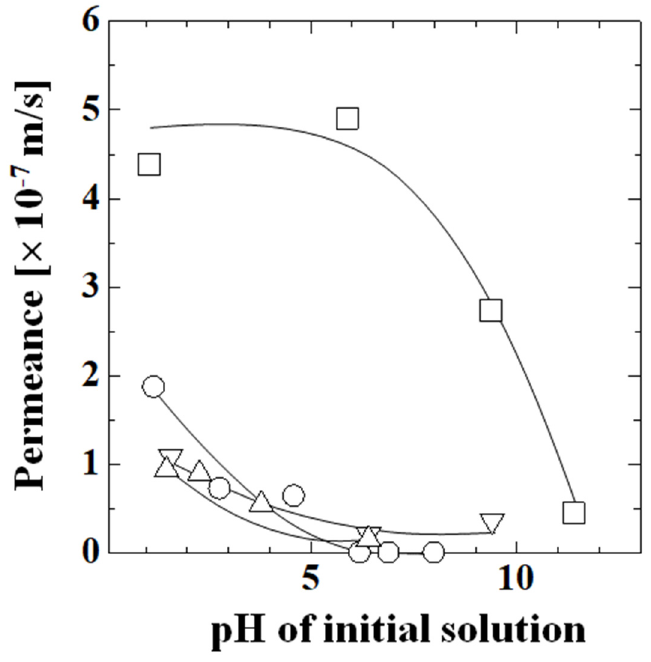
Figure 9. Permeance of each component in a single solution as a function of pH. Symbols: experi- mental values; lines: calculated values; ○: acetic acid; Δ : lactic acid; (cid:0) : phenol; and ∇ : caffeine.